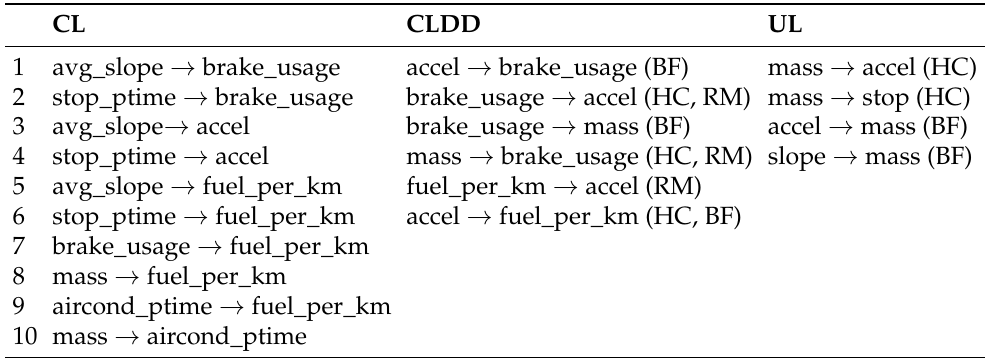
Table 2. Link collection found by the three Bayes networks: hill climbing (HC), restrictive maxi- mization (RM), and brute force (BF). The collection is grouped as common links (CL), common links with discordant direction (CLDD), and uncommon Links (UL). For CLDD and UL, we specify the networks for which the links are present.